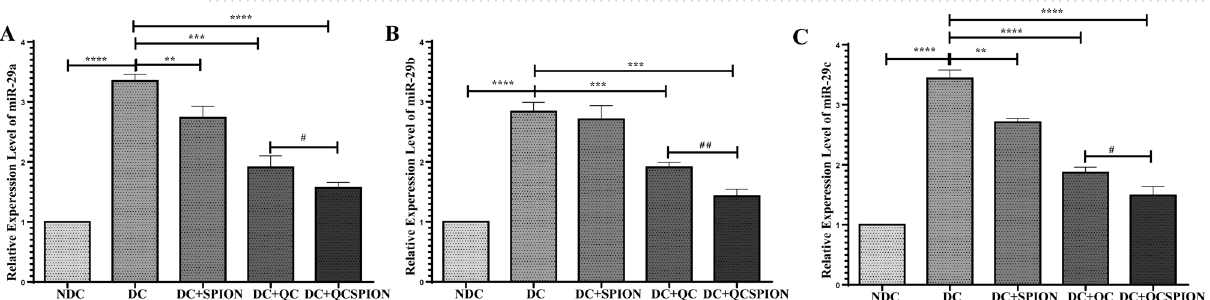
Figure 2. Effect of QC and QCSPIONs treatment on miR-29 family. ( A ) miR-29a, ( B ) miR-29b, ( C ) miR- 29c in the hippocampus of diabetic rats. Data are mean with SEM (n = 5 per group). **P < 0.01, ***P < 0.001 and P < 0.0001 vs DC group (One-way ANOVA, Tukey’s multiple comparison tests). # P < 0.05, ## P < 0.01 vs QCSPION group. NDC non-diabetic control, DC diabetic control, DC + SPION diabetic treated with superparamagnetic iron oxide nanoparticle, DC + QC diabetic treated with quercetin, DC + QCSPION diabetic treated with quercetin-conjugated superparamagnetic iron oxide